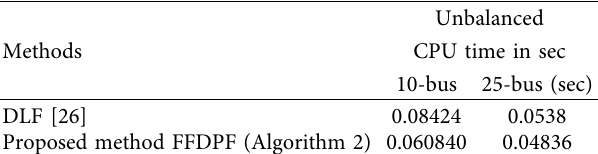
Table 4: Comparison of the CPU execution time of the balanced 10-bus and 25-bus